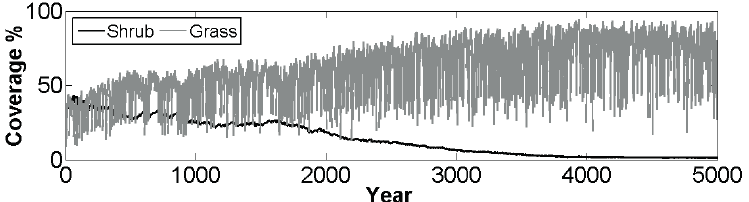
Fig. 2 Time series of percent coverage of PFTs in the modelled catchment over the 5000